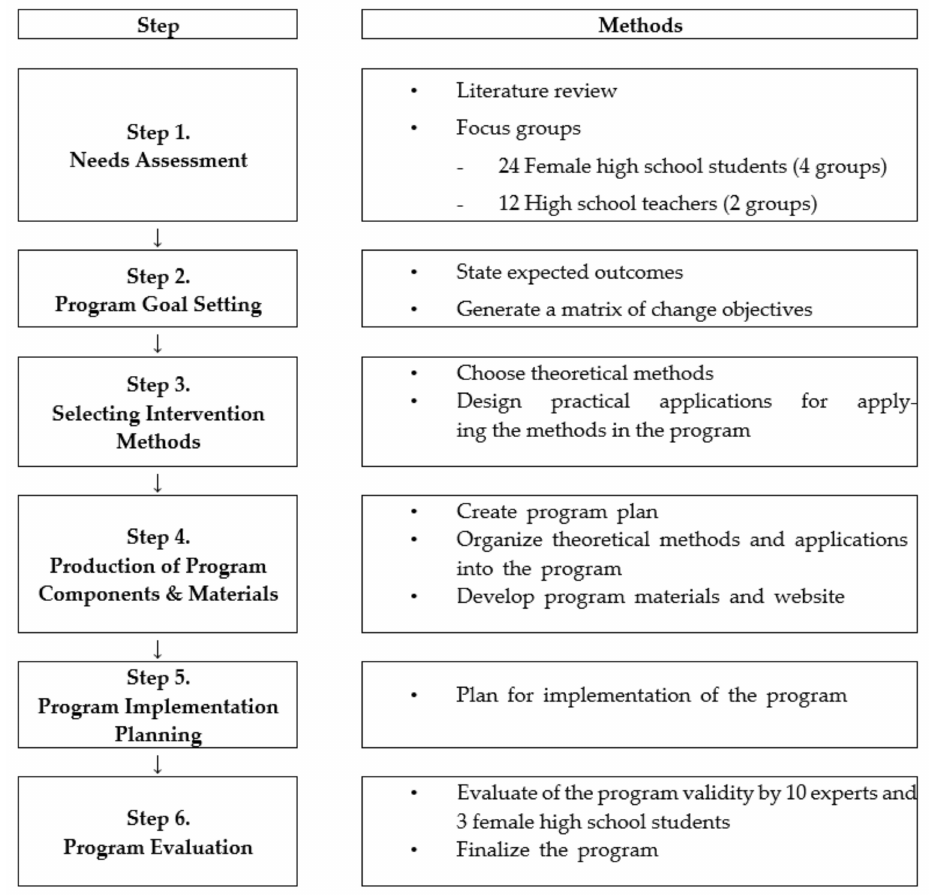
Figure 1. The process of program